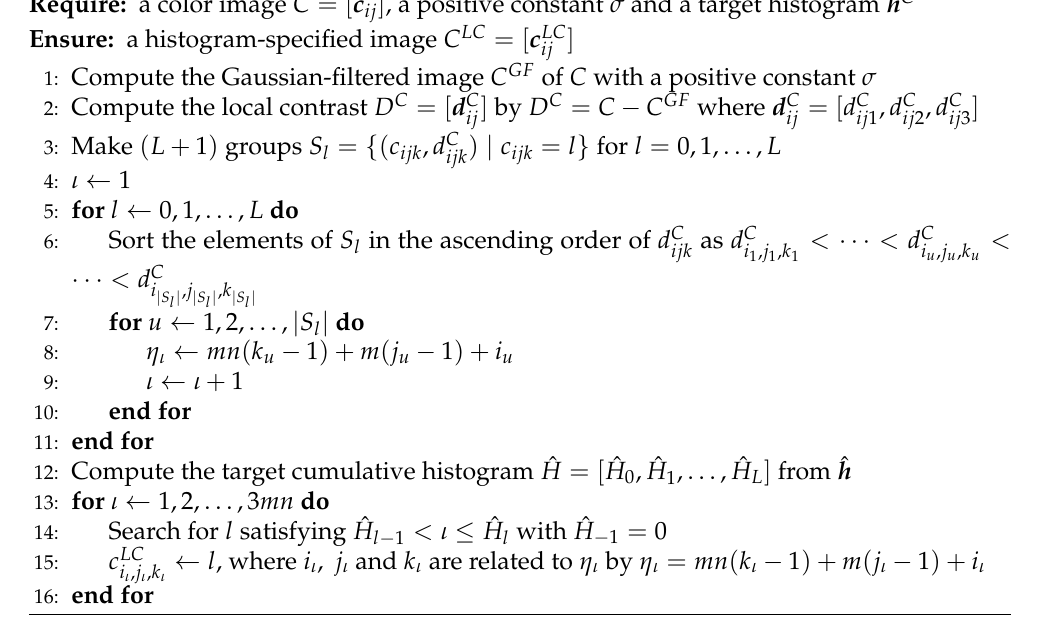
Algorithm 3 Local contrast-based exact histogram specification for color images